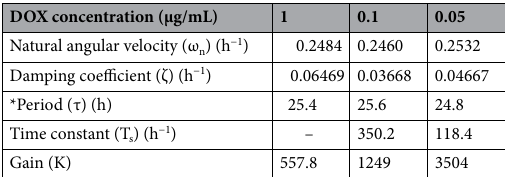
Table 3. Parameters of oscillation calculated for each DOX concentration. *Calculated by substituting the ω n and ζ values into Eq.